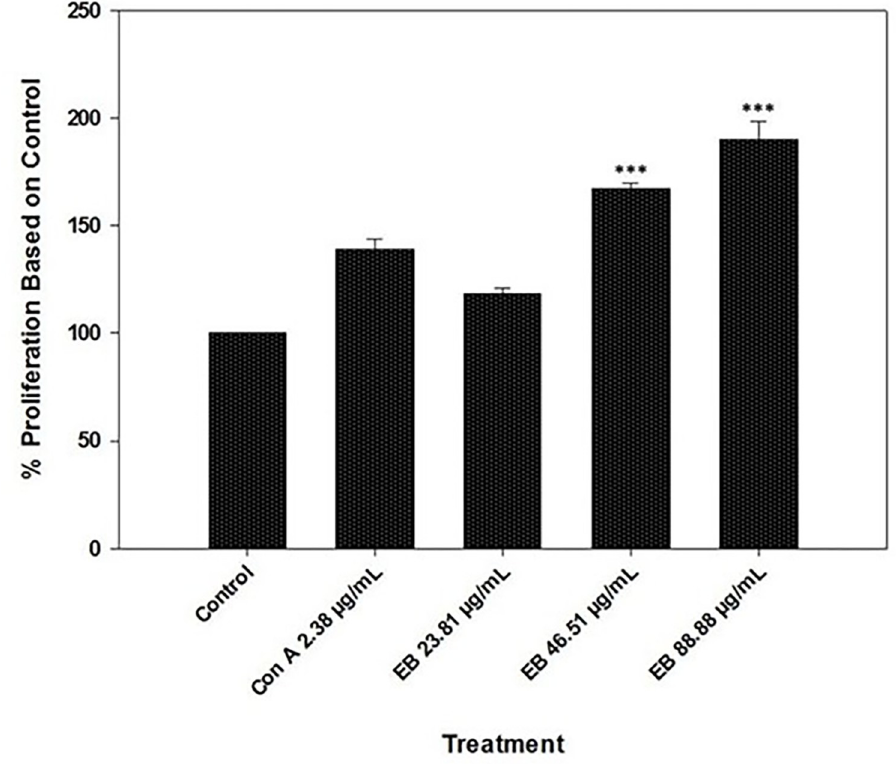
Fig 2. Proliferation of fish thymus T-cells in the prescence of Con A and various concentrations of elderberry extracts (23.81 μ g/mL, 46.51 μ g/mL, and 88.88 μ g/mL). All the elderberry extract concentrations were tested in the presence of Con A. Results are represented in means ± SEM. Asterisks represent a significant proliferation difference between treatment and control cell growth ( ��� = P < 0.001).